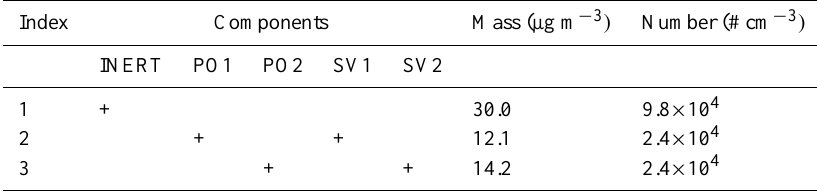
Table 5. Populations formed at t =188 h in base case external mixture simulation without coagulation.